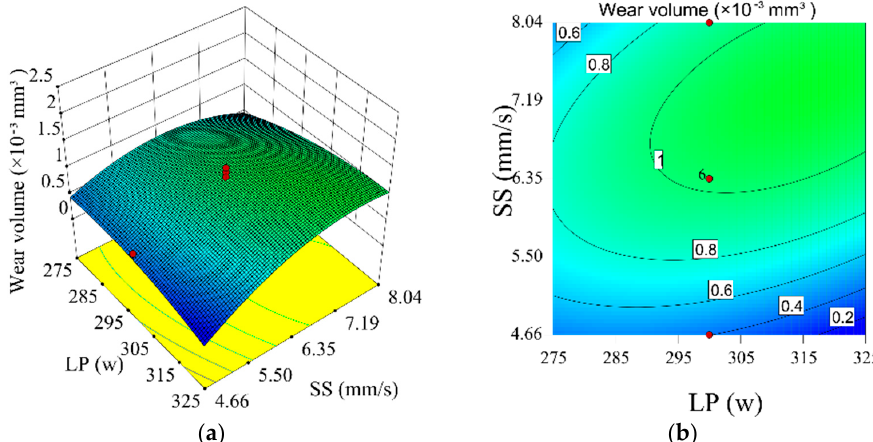
Figure 7. ( a ) 3D response surface showing the influence of laser power and scanning speed on wear volume. ( b ) Contour line of the response surface.